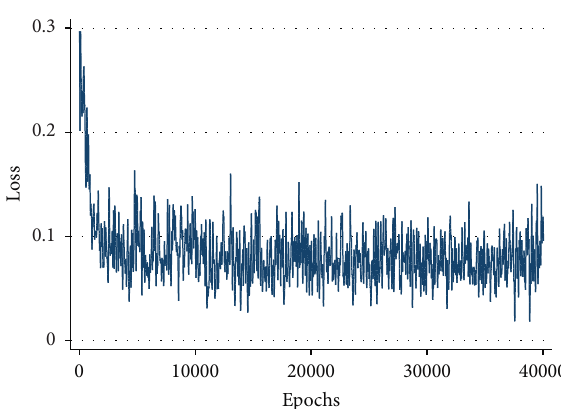
Figure 8: Loss function values of LSTM-CNN model.